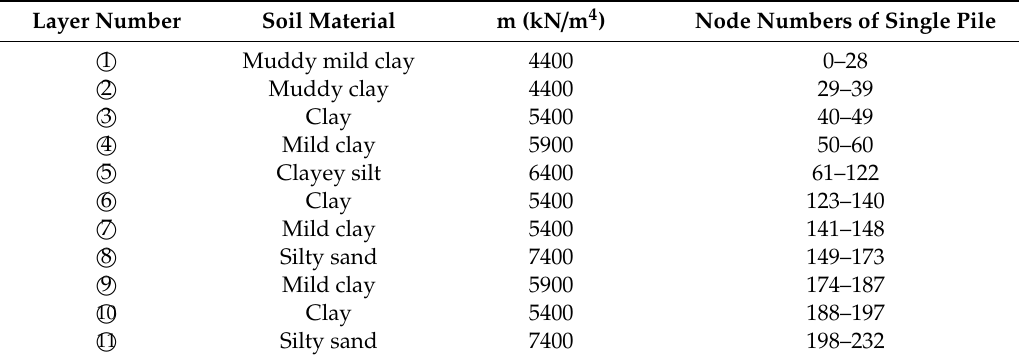
Table 6. Updated values of m after the iteration.